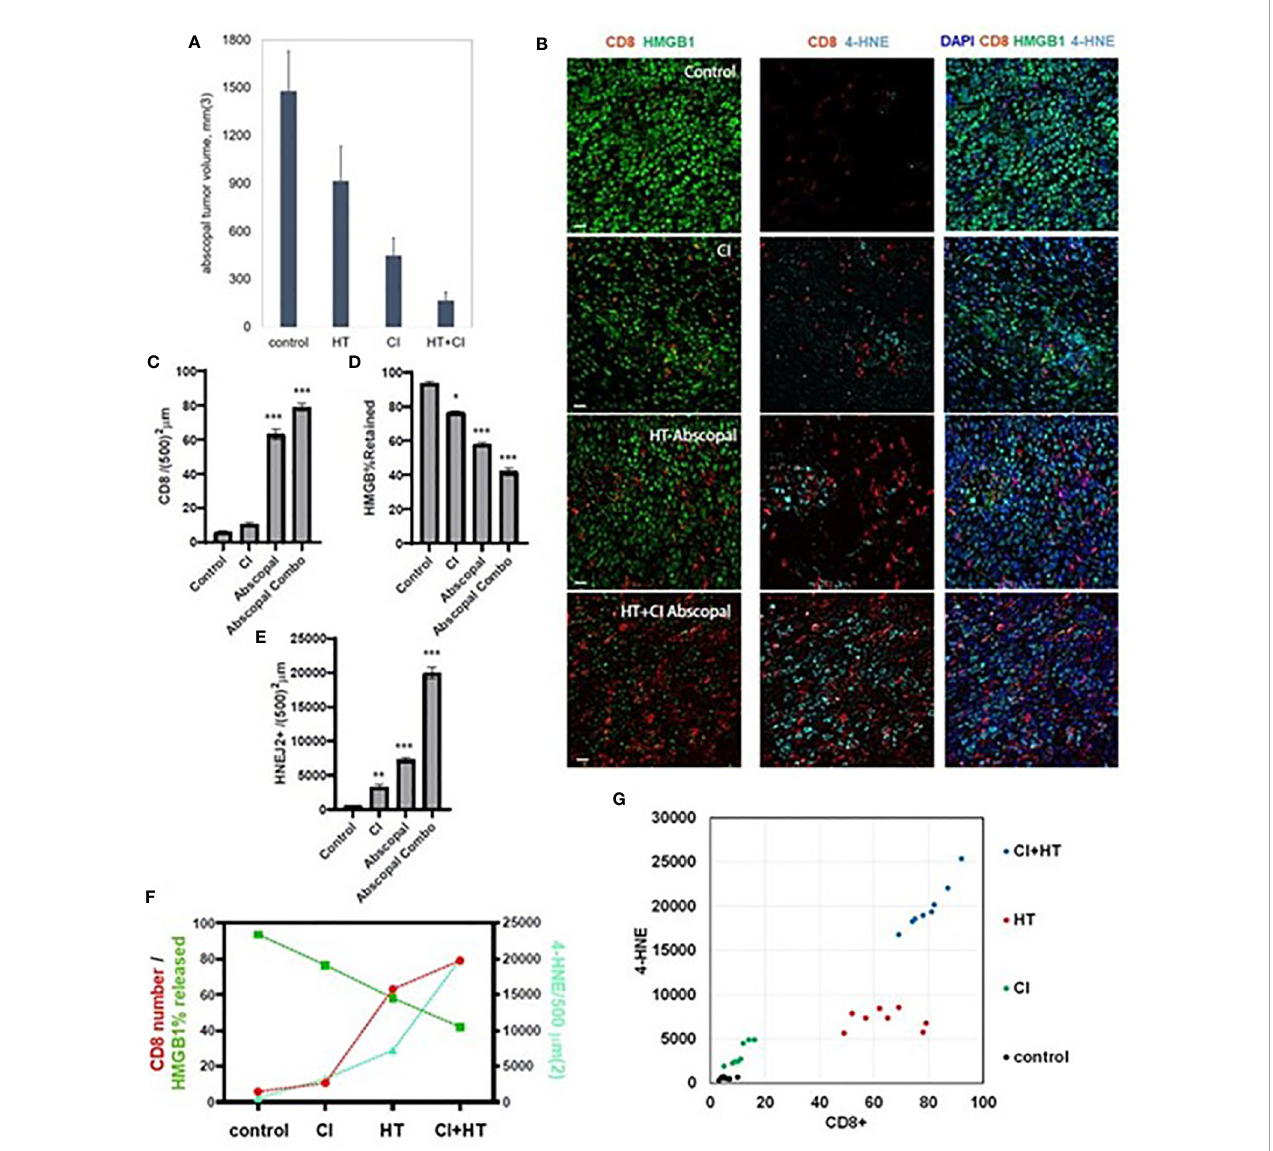
FIGURE 6 The combination of histotripsy with checkpoint inhibition results in additive intratumoral in fi ltration of CD8+ cells and synergistic induction of cancer cell ferroptosis. Mice bearing bilateral B16F10 tumors were treated with no therapy (control), checkpoint inhibition (CI) with anti-CTLA-4 mAb on days 6, 9 and 12 ( “ CI ” ), unilateral partial histotripsy ablation ( “ HT ” ) on day 7, or both ( “ HT+CI ” ). (A) Non-ablated abscopal tumor growth on day 18 was suppressed in mice treated with contralateral HT and CI, but maximal in mice treated with both. (B) Multicolor immuno fl uorescence of non-ablated abscopal tumors revealed increases in intratumoral CD8+ cell in fi ltration, loss of nuclear HMGB1, and 4-HNE accumulation after both CI and HT, with maximal effects seen after combinatorial HT+CI. (C) Quantitation of CD8+ cell density demonstrated an additive effect between CI and the abscopal effect of HT. (D) A similar additive effect was observed between CI and the abscopal effect of HT in extranuclear HMGB1 translocation. (E) The combination of HT+CI appeared to be a greater than additive effect on abscopal 4-HNE expression. The additive effects of CI and HT on abscopal CD8+ cell in fi ltration, HMGB1 release, and 4-HNE expression are shown in line graph form (F) and dot plot form (G) . (n=4-7 mice per group; *=p<0.05 compared with controls; **=p<0.01 compared with controls; ***=p<0.001 compared with